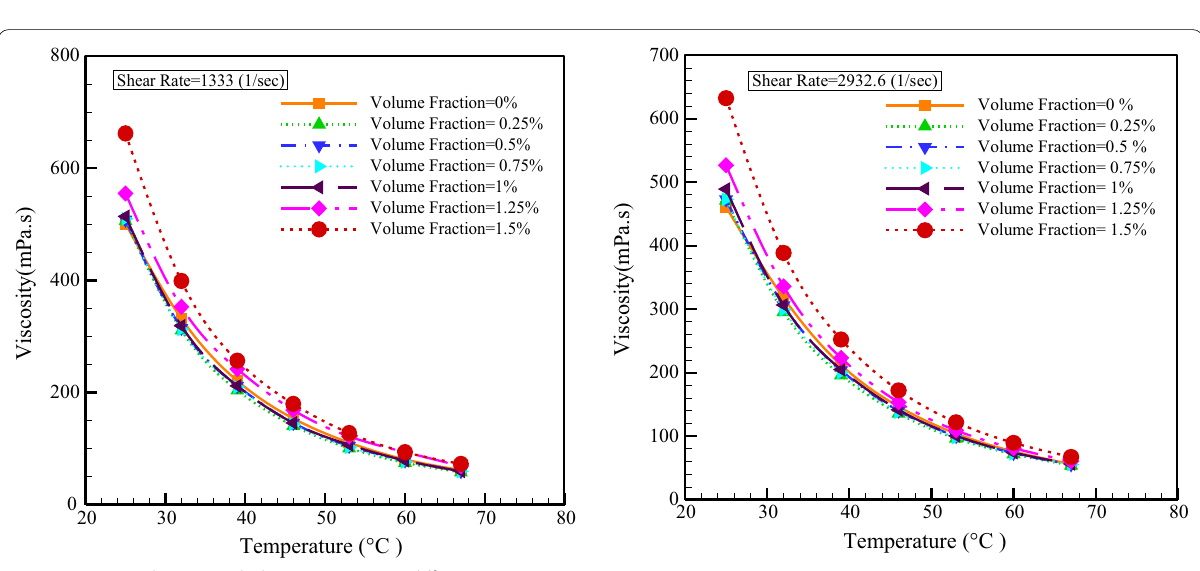
Fig. 9 Viscosity changes with the temperature at different